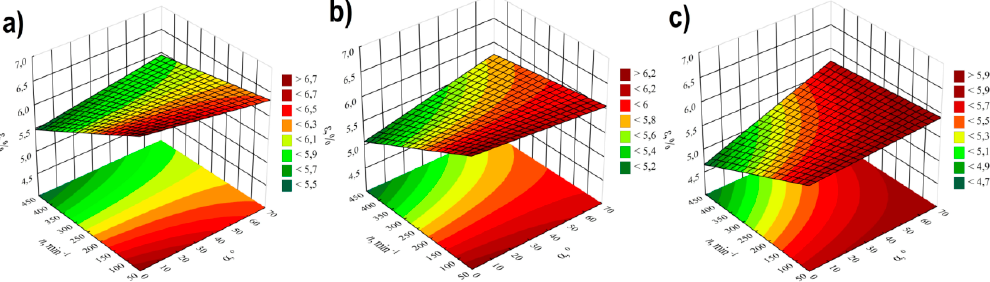
Figure 11. Response surface plots of elongation at tensile strength ε based on screw rotational speed n and angle of rotation of the kneading elements α , with a talc content of ( a ) u = 10%; ( b ) u = 13%; ( c ) u = 16%.